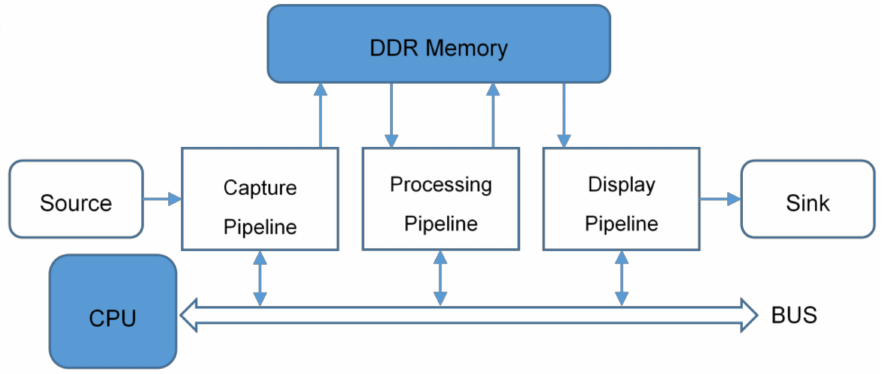
Figure 2. The data-flow pipeline control performing partial reconfiguration of the hardware modules